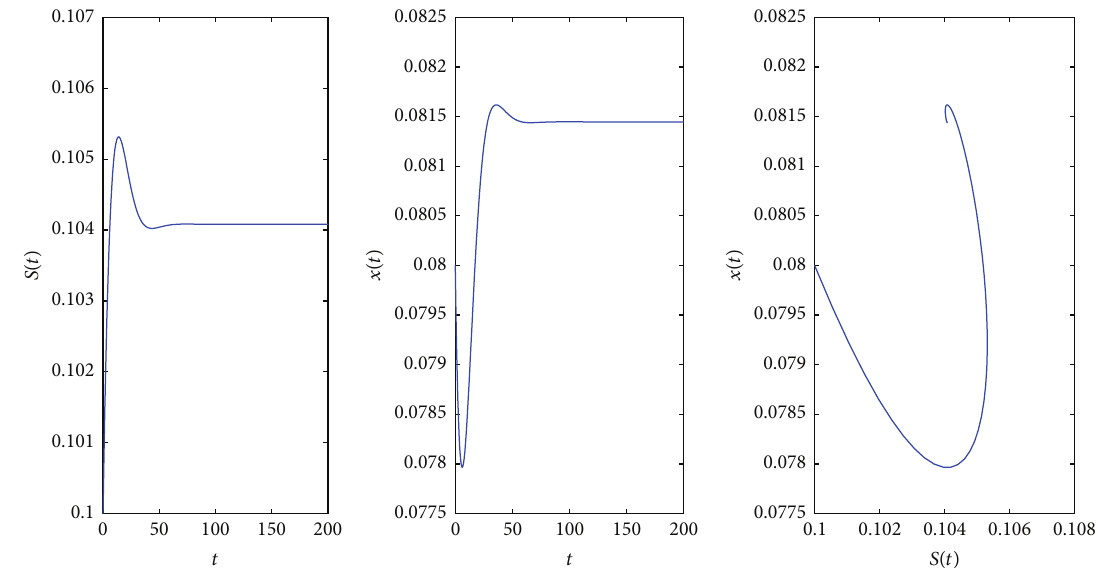
Figure 1: Asymptotic stability. The steady state 𝐸 ∗ is locally asymptotically stable. The parameters are 𝐷 = 0.01 , 𝐷 1 = 0.5 , 𝛾 = 0.8 , 𝑘 = 0.1 , 𝑎 = 1 , and 𝑆 0 = 1 . The time delays are 𝜏